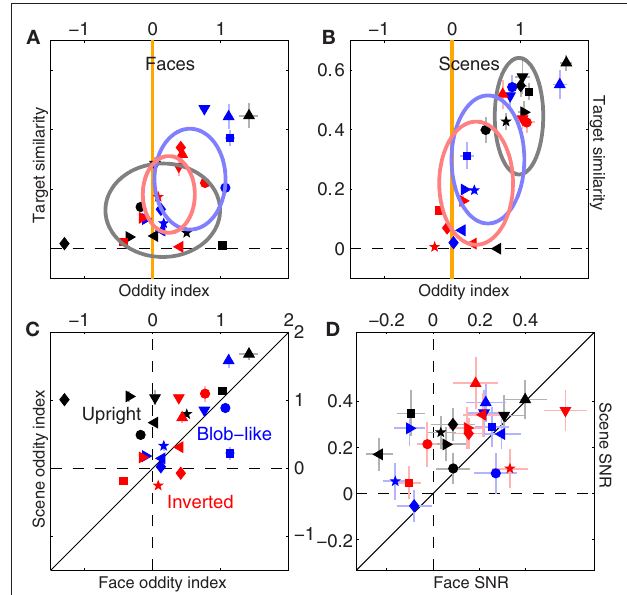
Figure 13 | Differential effect of scenes versus faces on filter shape. (A,B) Are plotted to the same conventions of Figure 5C , separately for faces (A) and scenes (B) . (C) Plots oddity index for scenes ( y axis) versus faces ( x axis); (D) reports filter SNR using similar plotting conventions. Data has been pooled from both natural and